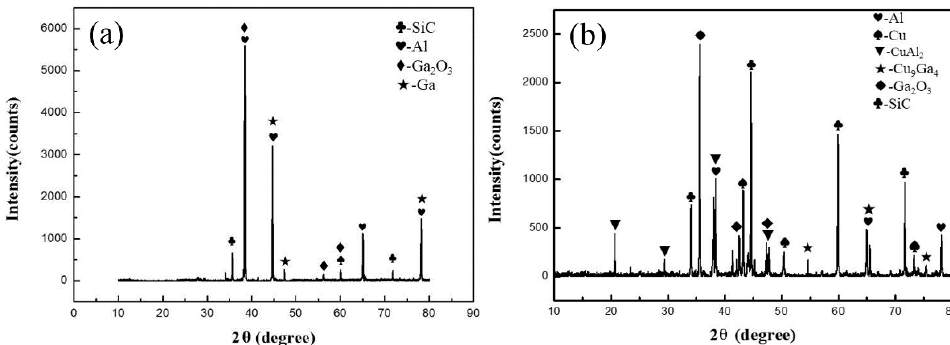
Figure 9. XRD results of the joint fracture bonded using: ( a ) liquid Ga at 440 °C; ( b ) Cu NPs and liquid Ga at 450 °C.